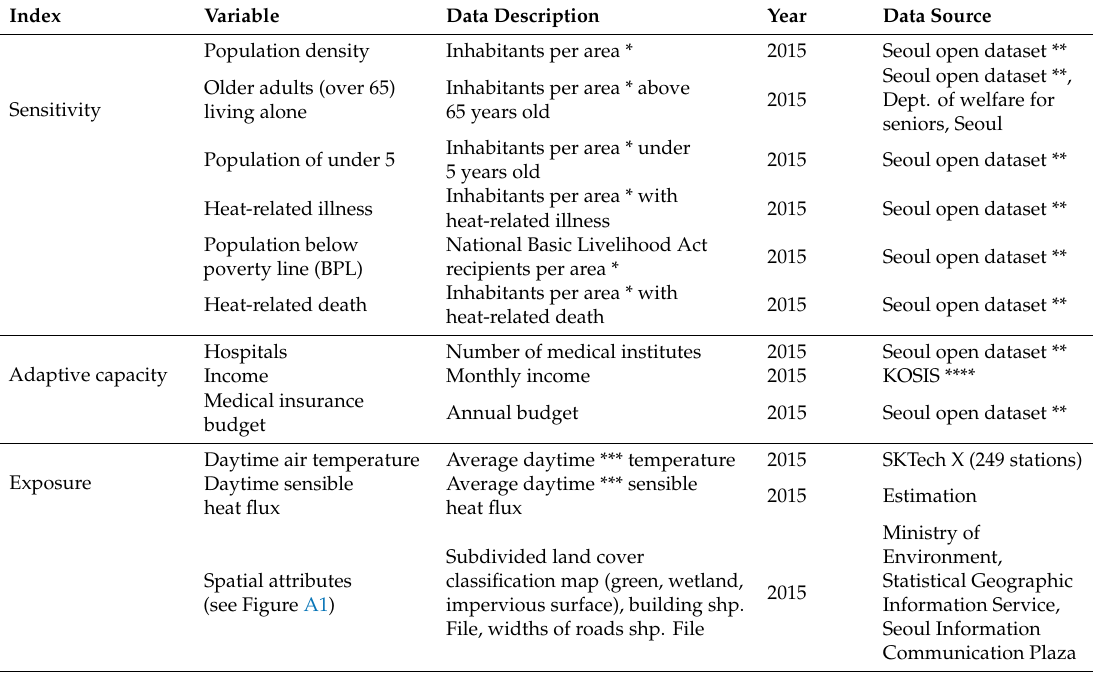
Table 2. Thermal vulnerability index